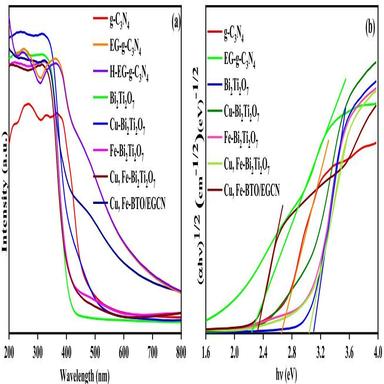
UV-DRS spectra of the (a) g-C3N4, EG-g-C3N4, H-EG-g-C3N4, Bi2Ti2O7, Cu-Bi2Ti2O7, Fe-Bi2Ti2O7, Cu, Fe-Bi2Ti2O7, and Cu, Fe-BTO/EGCN, (b) Corresponding tauc plot.